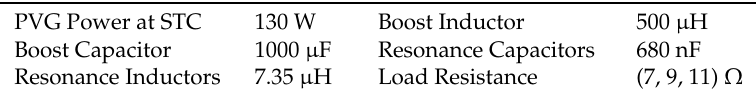
Table 7. Parameters of the complete WPTS.